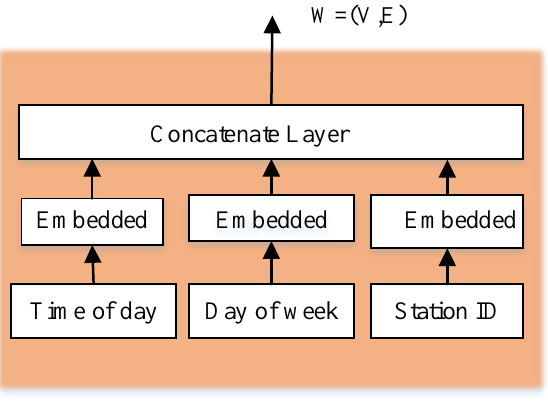
Figure 2. Embedding extraction of discrete features.